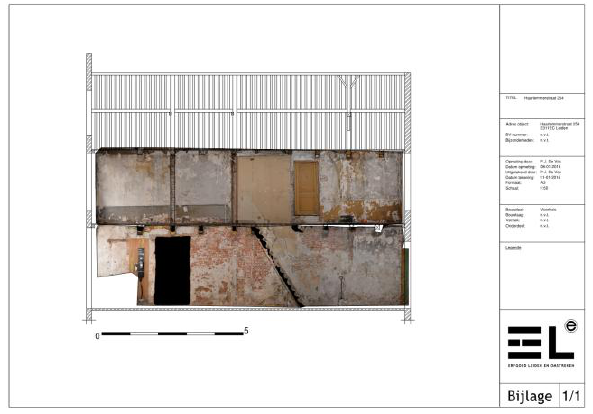
Figure 5. Section drawing of Haarlemmerstraat 254 in Leiden (dated 1409) based on architectural drawings and detailed